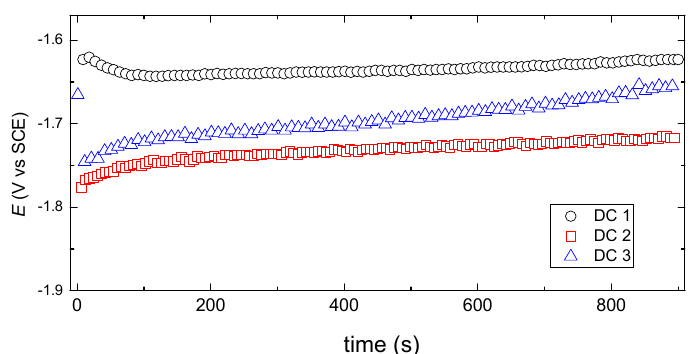
Figure 1. Cathode potential versus deposition time for DC deposited samples.